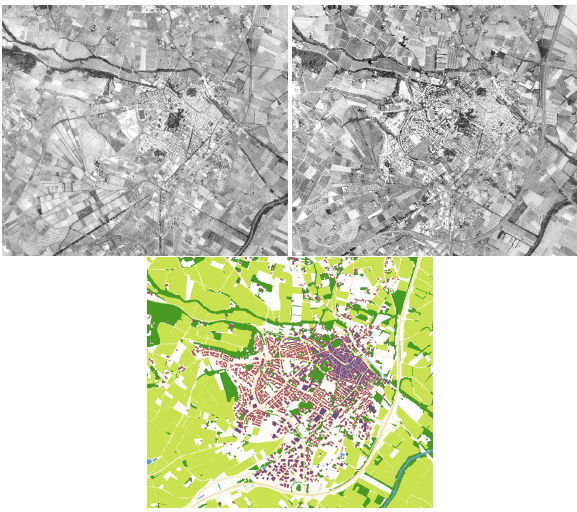
Figure 4. Top row from left to right: 1981 and 2001 images. Bottom row: ground truth generated out of current